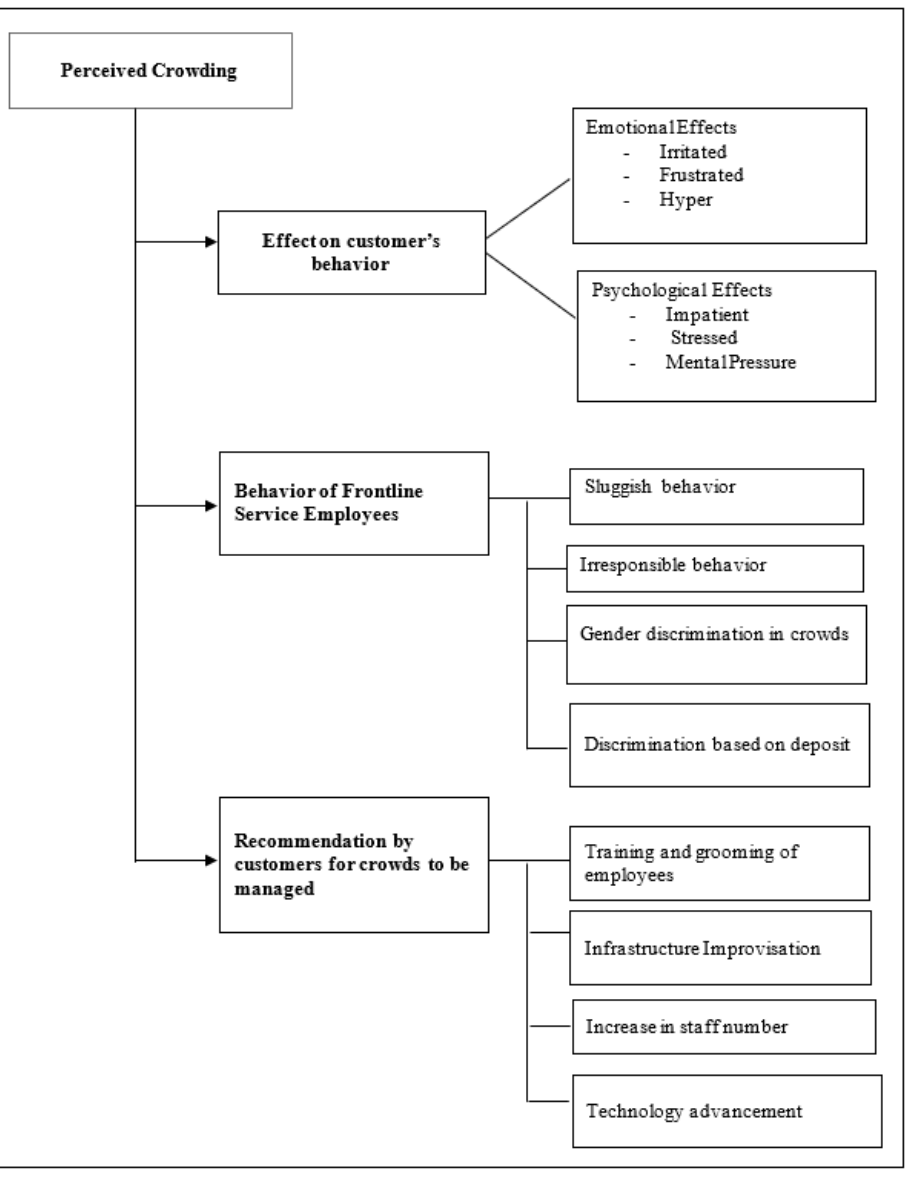
Figure 2: Extracted